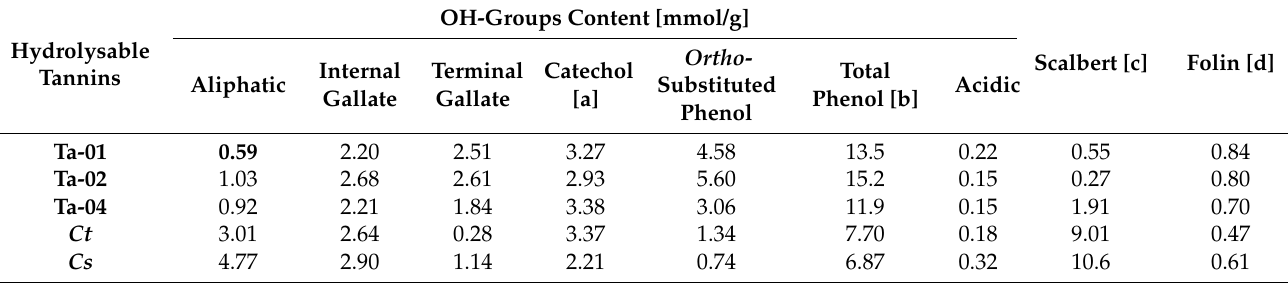
Table 4. Results of quantitative 31 P NMR analyses of phosphitylated commercially available hydrolysable tannins, number average molecular weights and polydispersities as well as proanthocyanidin contents and total phenolic OH-group content. OH-Groups Content Hydrolysable Tannins